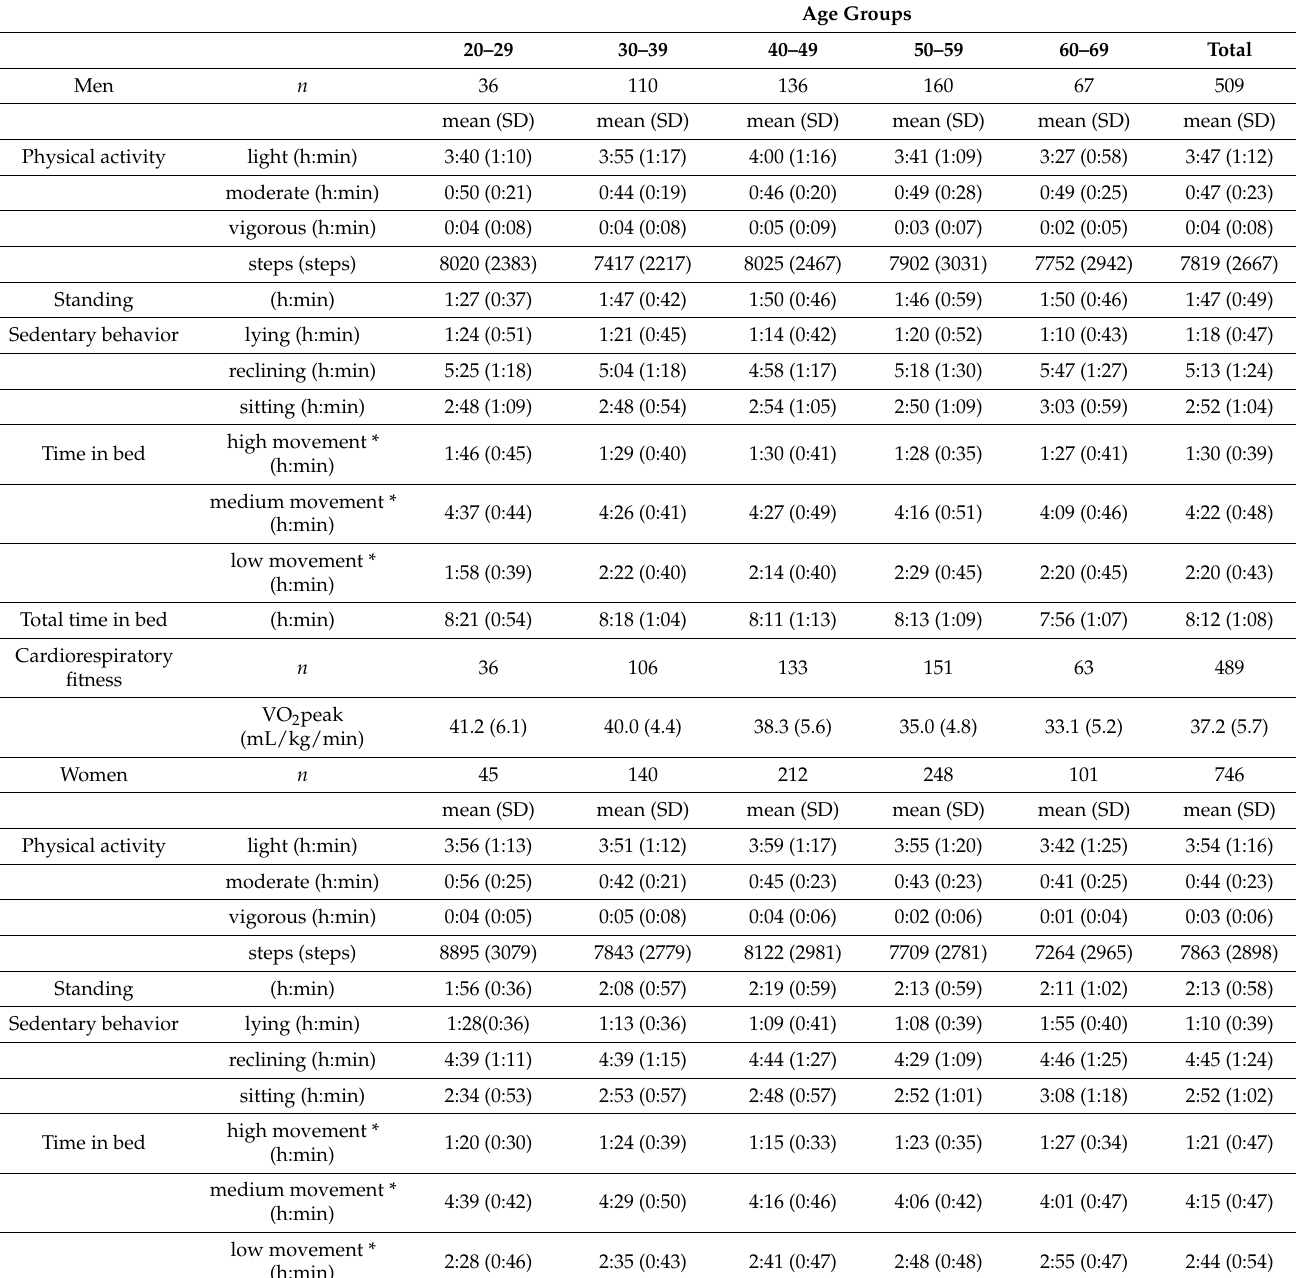
Table 1. Participants’ daily physical behavior and cardiorespiratory fitness broken down by age group and